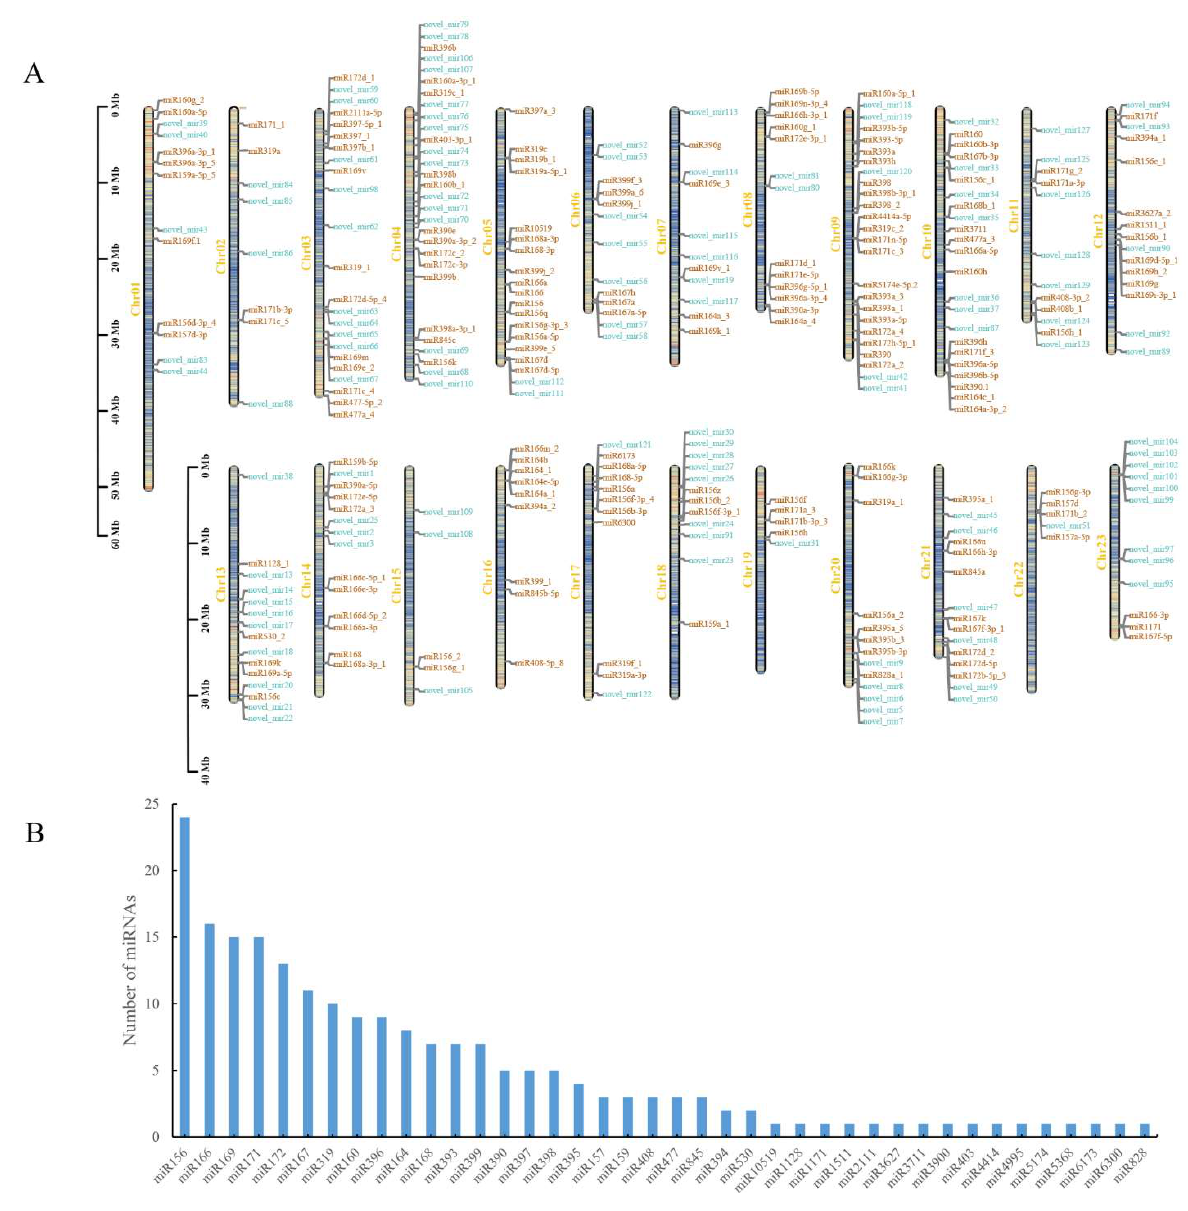
Table 1. Data information for small RNA sequencing.